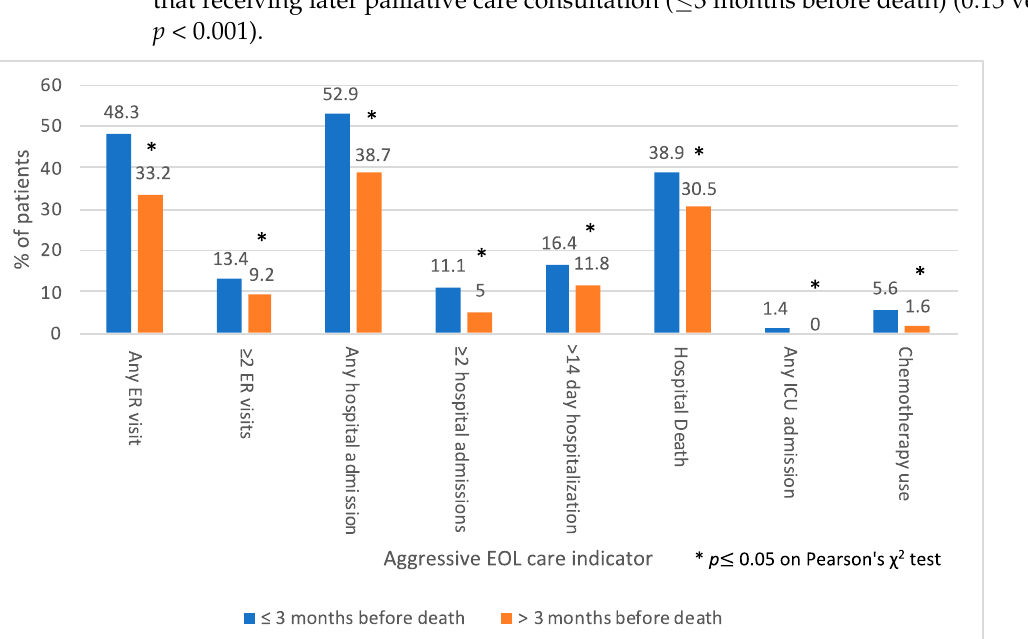
Figure 4. Proportions of indicators of aggressive care at the end of life (EOL) in last 30 days of life, based on timing of palliative care (PC) consultation ( N = 1414).